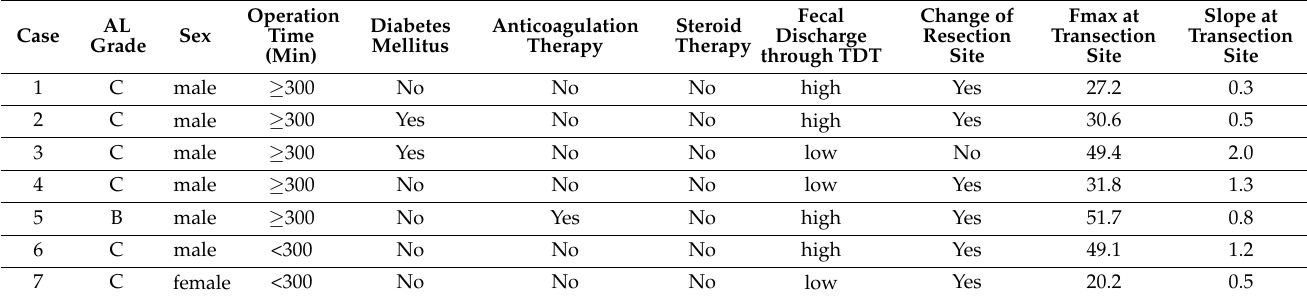
Table 2. Clinical characteristics of the AL